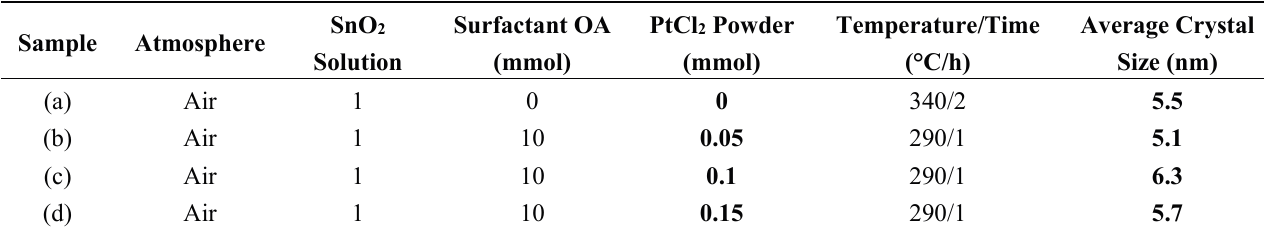
Table 1. Experimental reaction conditions for pure and Pt-loaded SnO 2